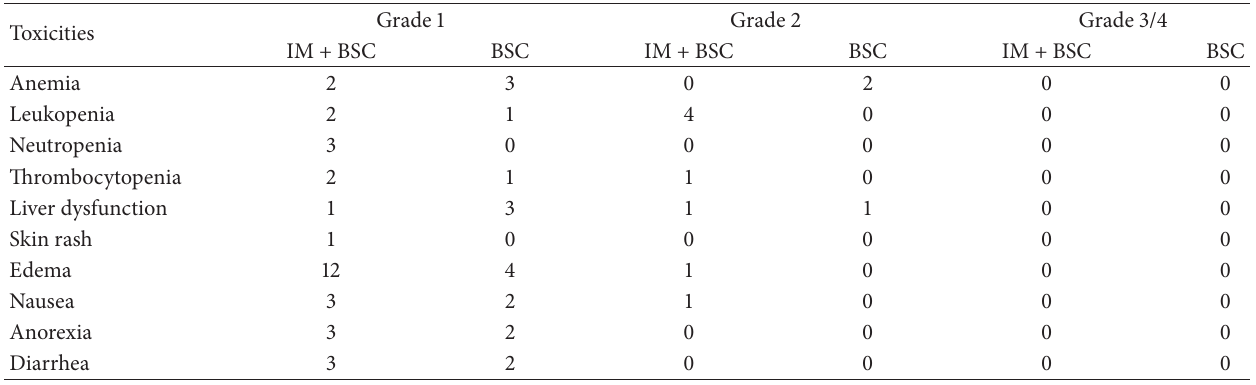
Table 3: Adverse